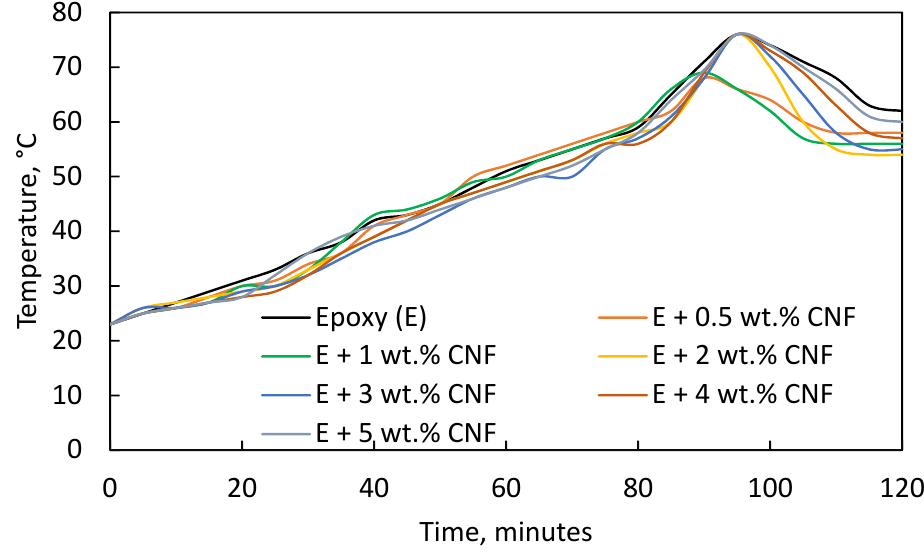
Figure 3. Time–temperature gelation of unfilled and CNF-filled epoxy nanocomposite series.